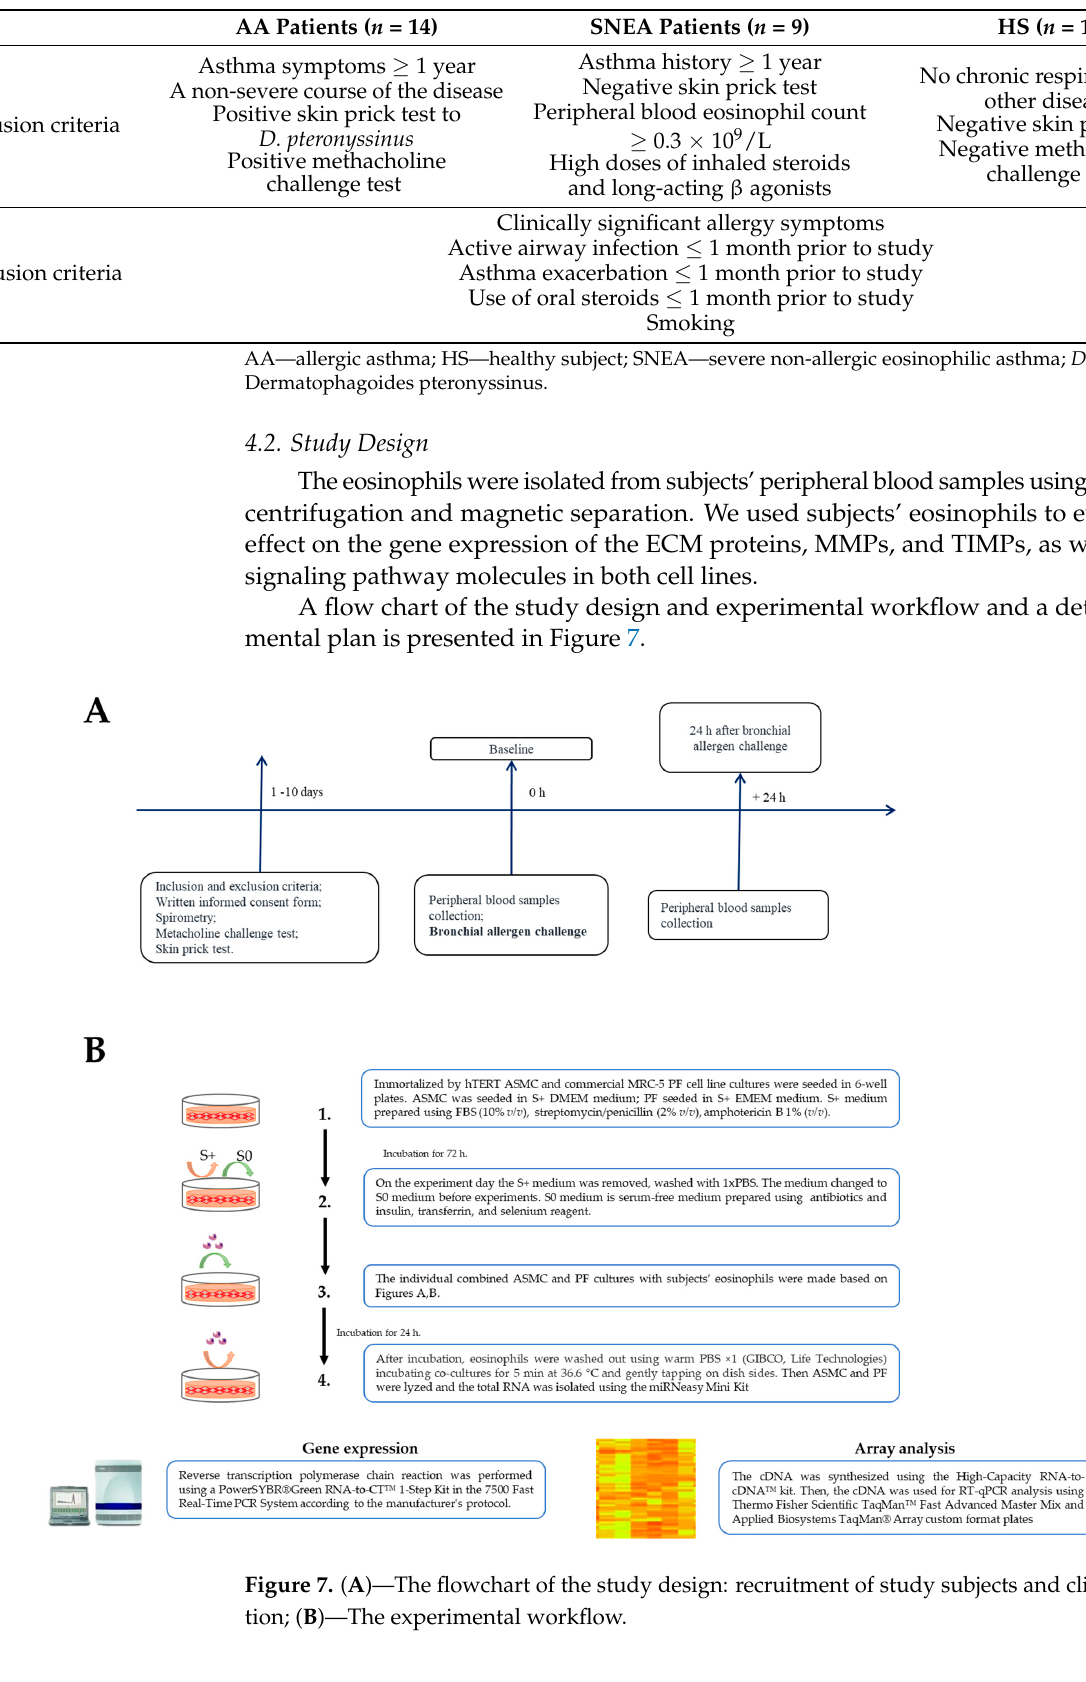
Table 2. Inclusion and exclusion criteria for the study population.